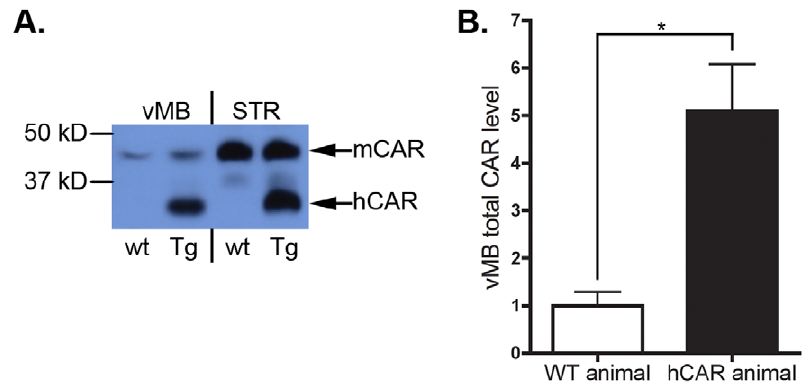
Figure 5. CAR expression in wild type and hCAR transgenic brain. Regional analysis of CAR protein shows variability in expression levels, which are elevated in hCAR transgenic animals. ( A ) A representative immunoblot of CAR protein levels in the ventral midbrain (vMB) and striatum (STR) shows large differences in expression. The truncated transgenic hCAR protein is seen running with a lower apparent molecular mass. Both mCAR and hCAR are visualized with the pan-CAR antibody H300. Transgenic hCAR is expressed in both the vMB and STR at a similar level to that of STR mCAR. ( B ) Quantitation of total CAR in the ventral midbrain by combining endogenous mCAR and transgenic hCAR shows five-fold more CAR protein available in this region in hCAR animals. Total CAR protein level of wt animals is considered baseline. Statistical significance assigned using two-tailed Student’s t -test (* indicates P , 0.02).